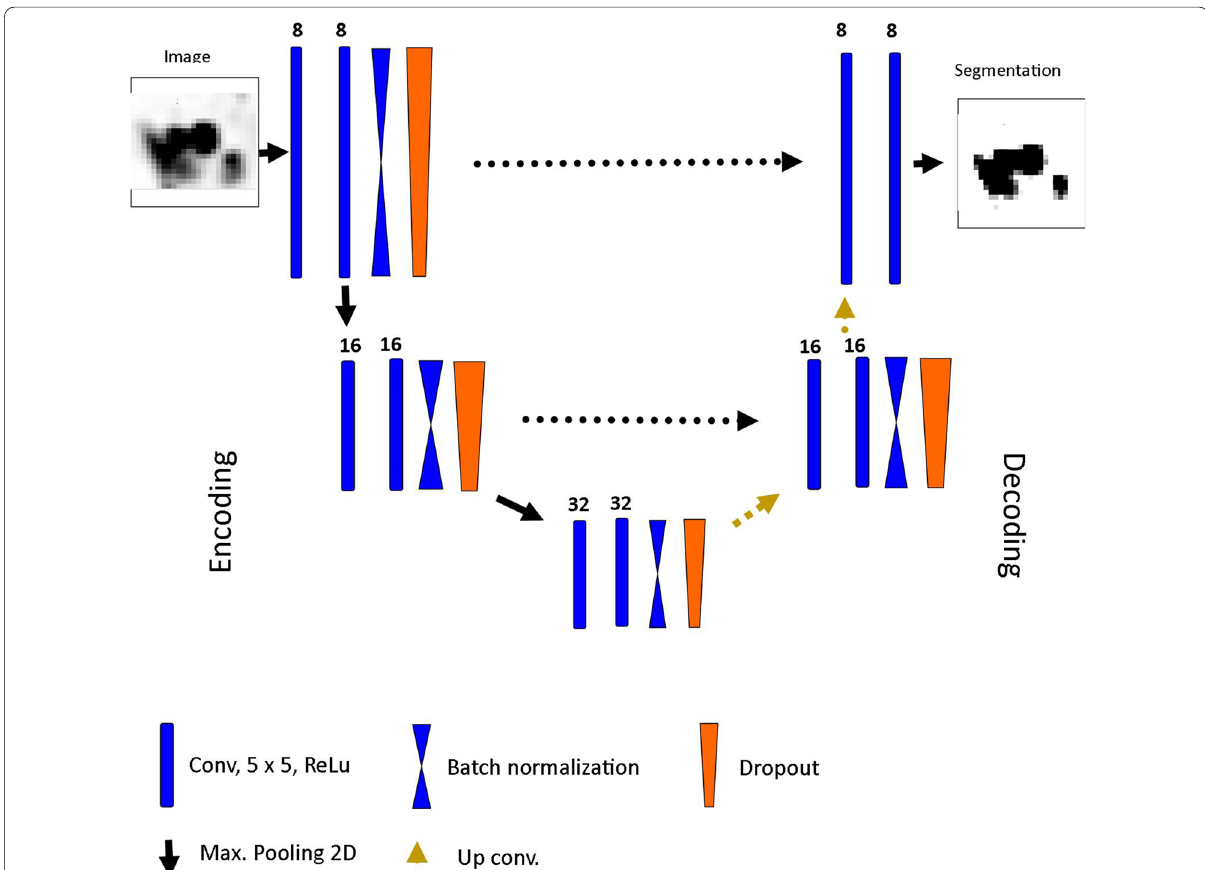
Fig. 2 CNN architecture: In the encoding path, the images are subsequently downsampled while the number of features increases. In the decoding path, the images are upsampled while the number of features decreases. Encoding and decoding path are connected with skip